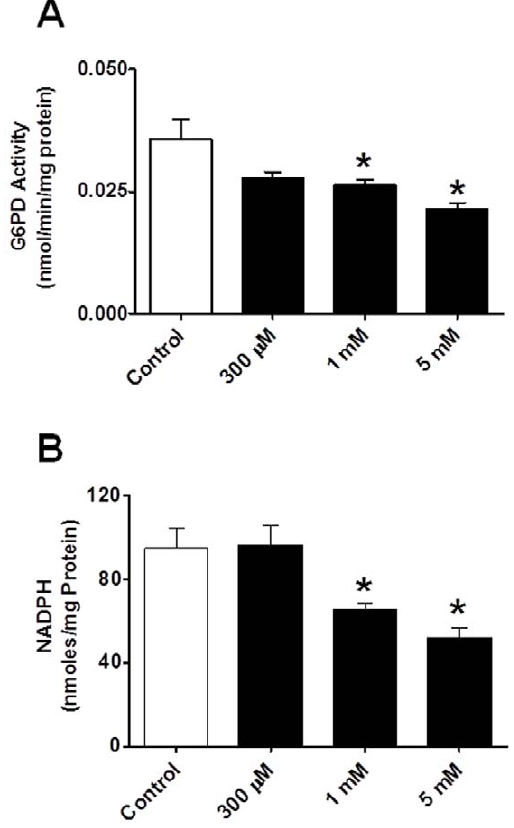
Figure 1. G6PD activity and NADPH levels. Application of 6AN (0.3–5 mM; A and B) for 10 minutes at 37 u C to rat hearts